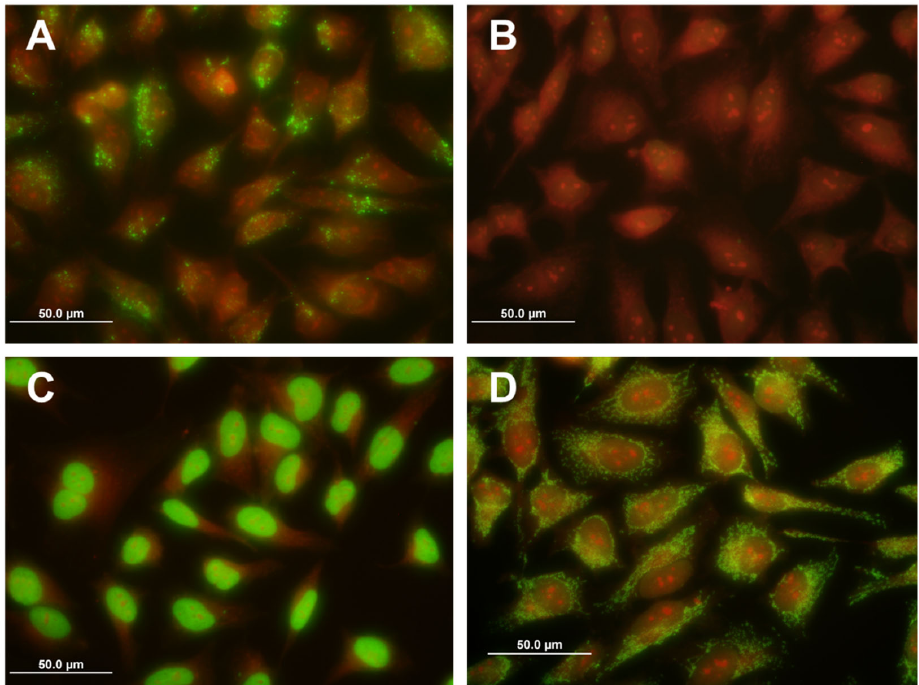
Figure 3. Fluorescence patterns observed in the study. ( A ) Positive reaction to Bartonella antibodies, ( B ) negative reaction, ( C ) antinuclear antibodies (ANAs), ( D ) antimitochondrial antibodies (AMA). Images were created using the software assembly of images in green and red fluorescence channels at a total magnification of 400×.